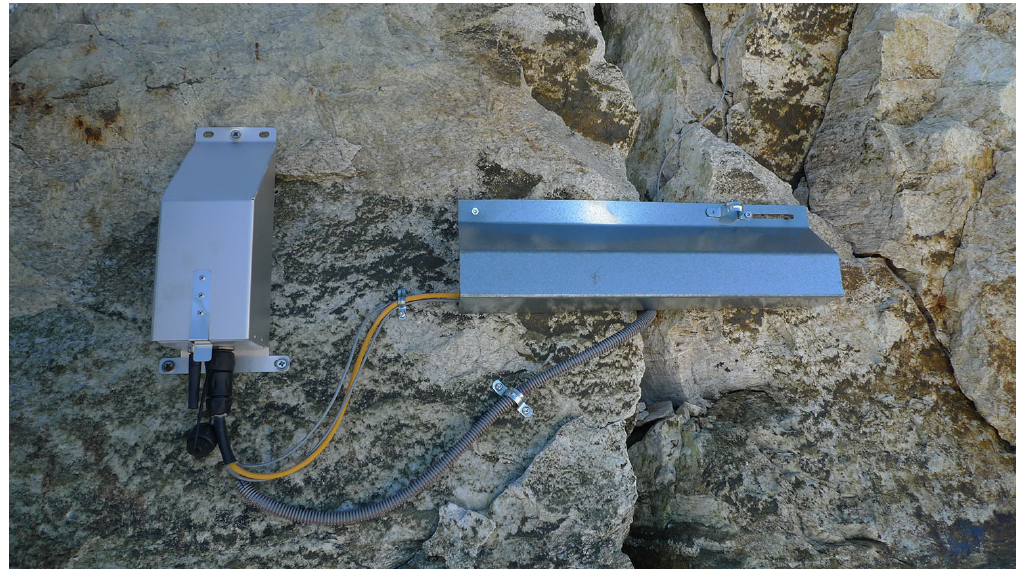
Figure C5. Close-up of crackmeter and thermistor chain installation at position MH03. The wireless sensor node is housed in the steel protective shoe on the left while the crackmeter is located under the steel protective shield in the middle.